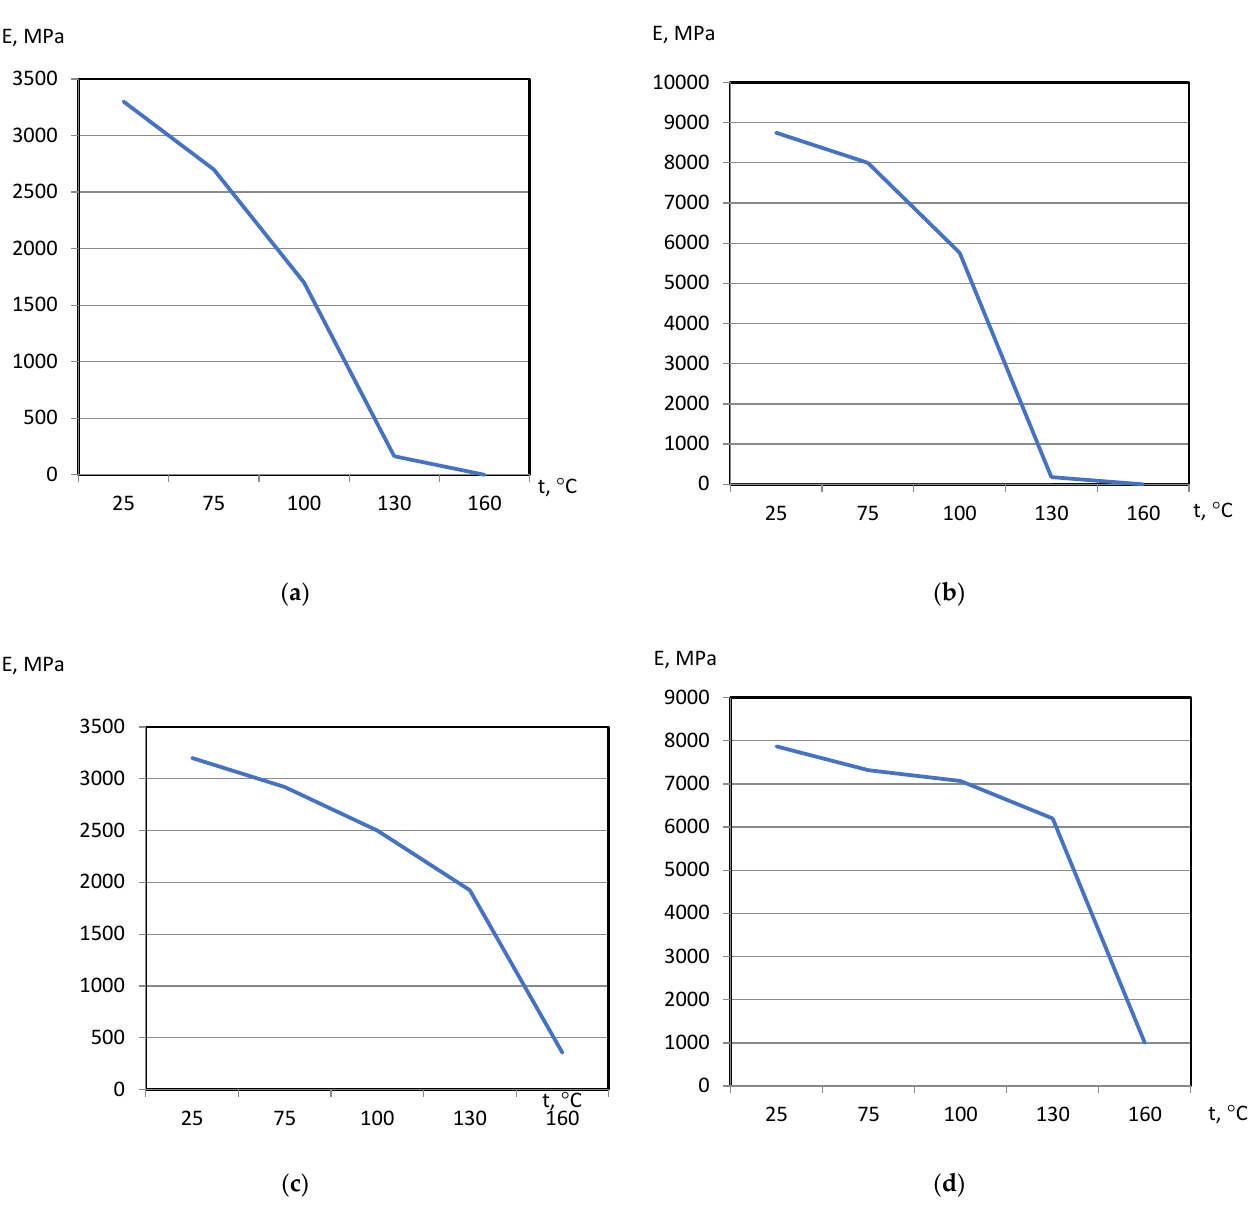
Figure 4. Polymers’ MoE under heating curves: ( a ) EP, ( b ) EP+FA, ( c ) EP after TR, ( d ) EP+FA after TR.